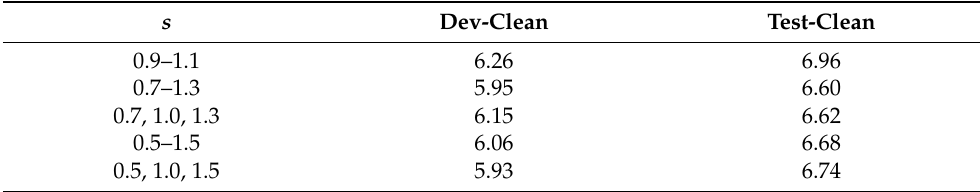
Table 4. WER (%) results of LibriSpeech database according to frame rate s when n = 1200. s